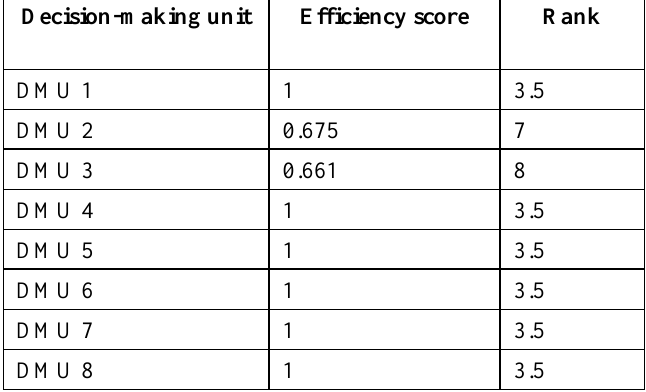
Table 4. Efficiency Sores and Ranks of Real Estate Firms in the Post- demonetization Period (developed by author) Decision-making